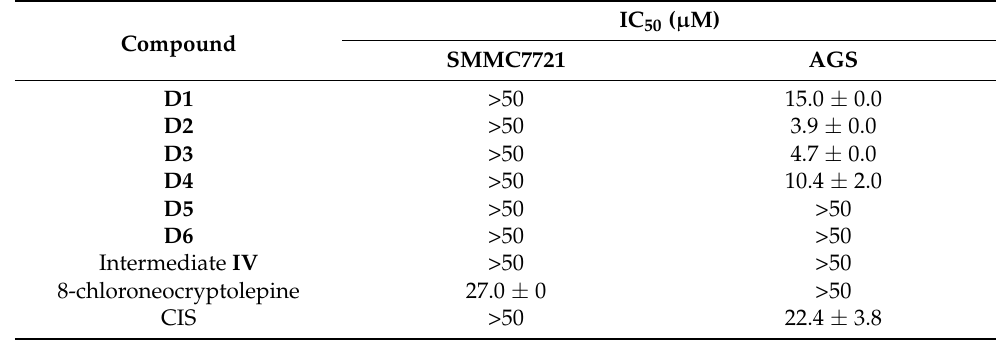
Table 5. Antiproliferative activities (IC 50 , µ M) of compounds D1-D6 and E1 on SMMC7721 and AGS cells for 48